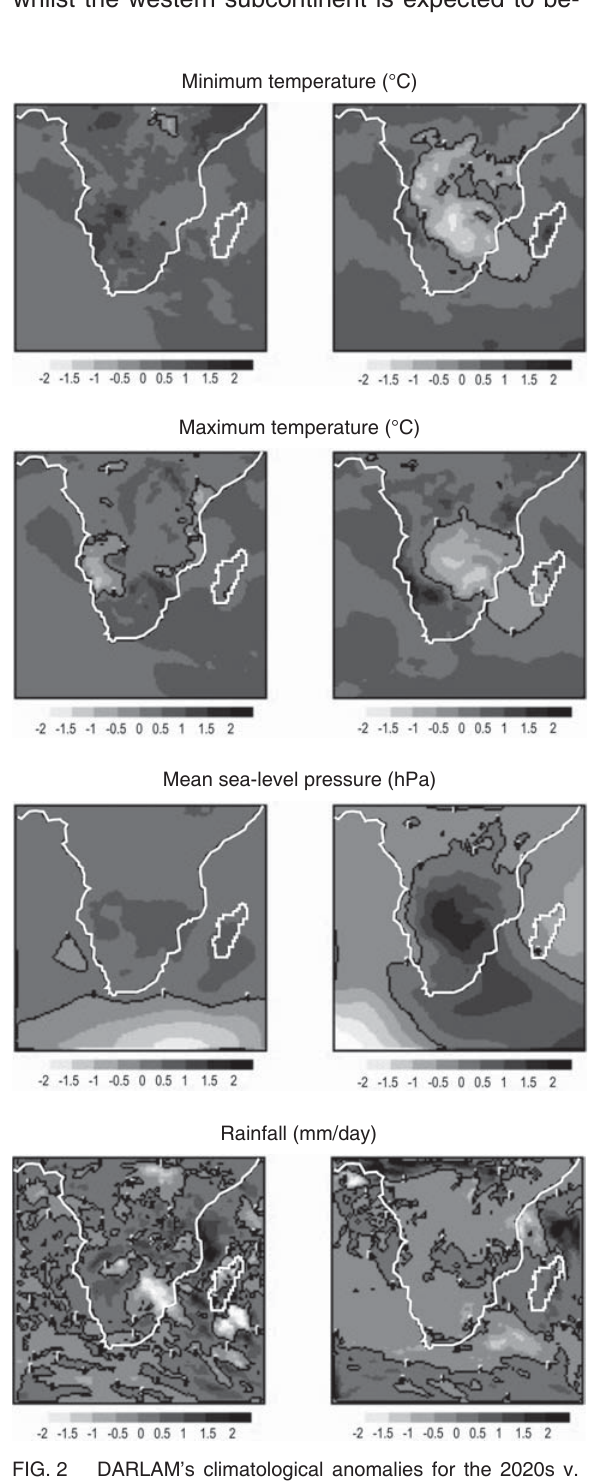
FIG. 2 DARLAM’s climatological anomalies for the 2020s v.